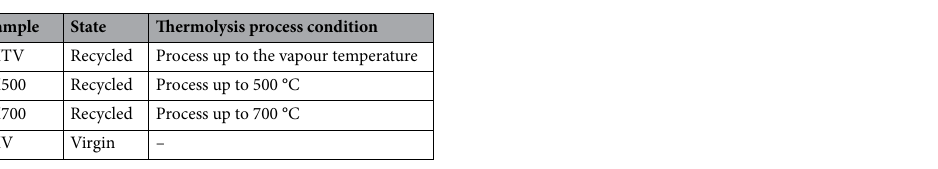
Table 1. Summary of the recycling process samples.